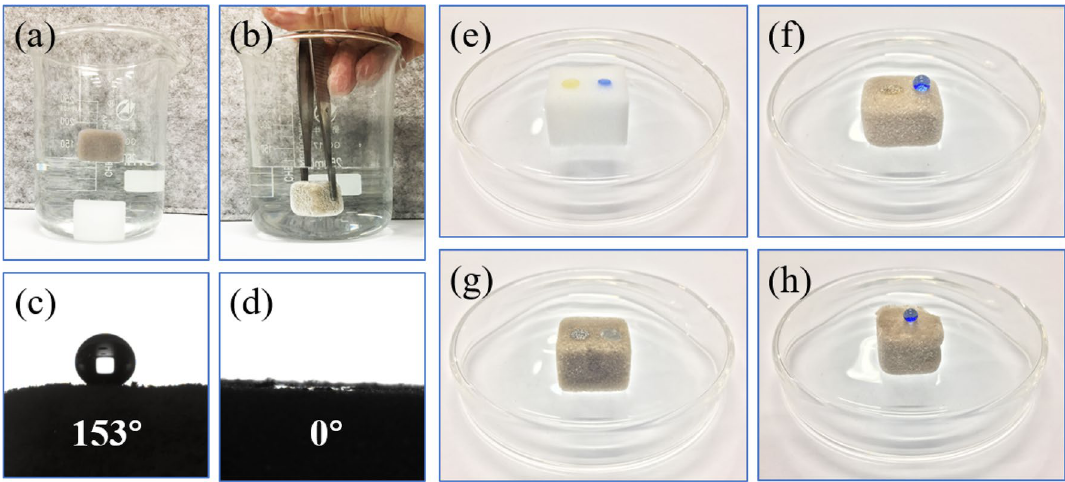
Figure 7. ( a ) Floating experiments of raw MS and OTS-PDA-MS. ( b ) Immersion experiment of OTS-PDA-MS. ( c , d ) WCA and oil CA test of OTS-PDA-MS. Photographs of oil and water droplets on ( e ) raw MS, ( f ) PDA-MS and ( g , h )